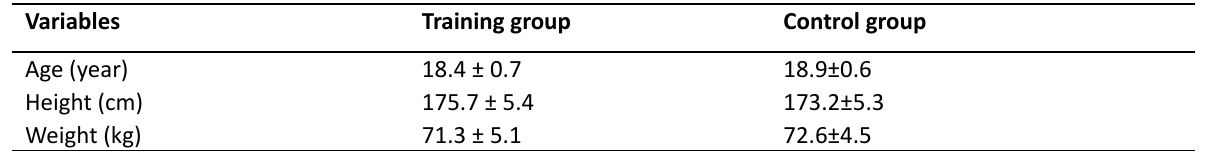
Table 1. General characteristics of the subjects Variables